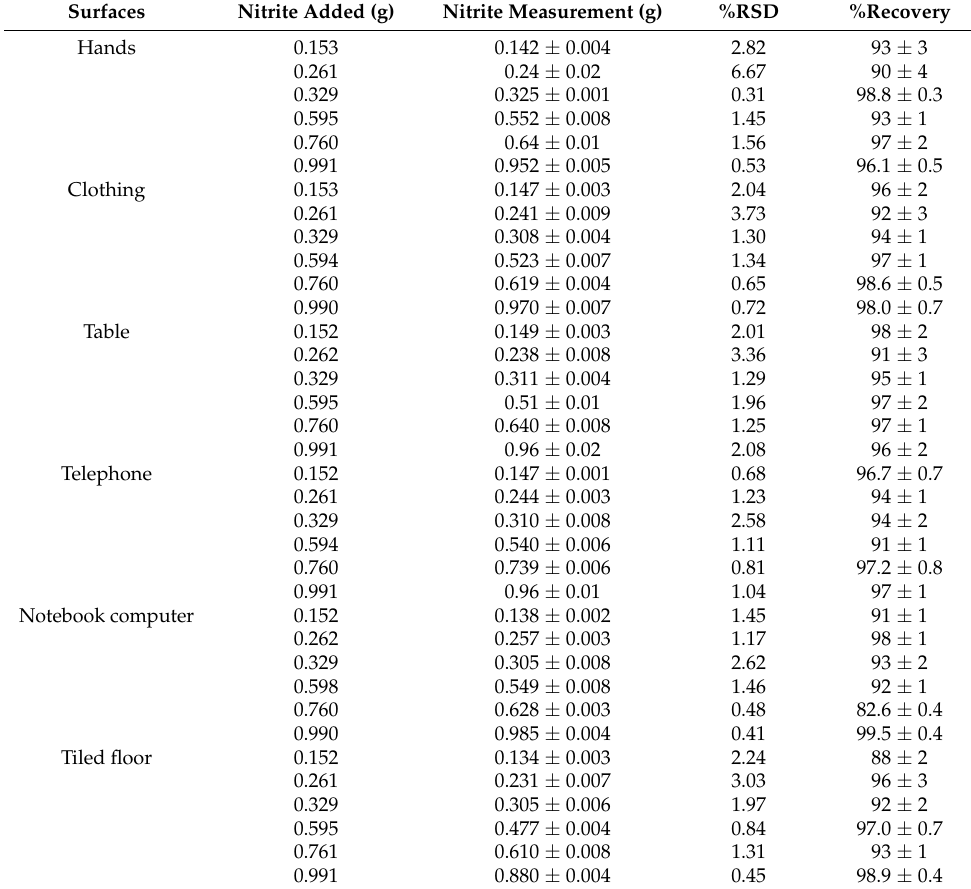
Table 3. Recovery analysis of nitrite samples on different surfaces ( n =